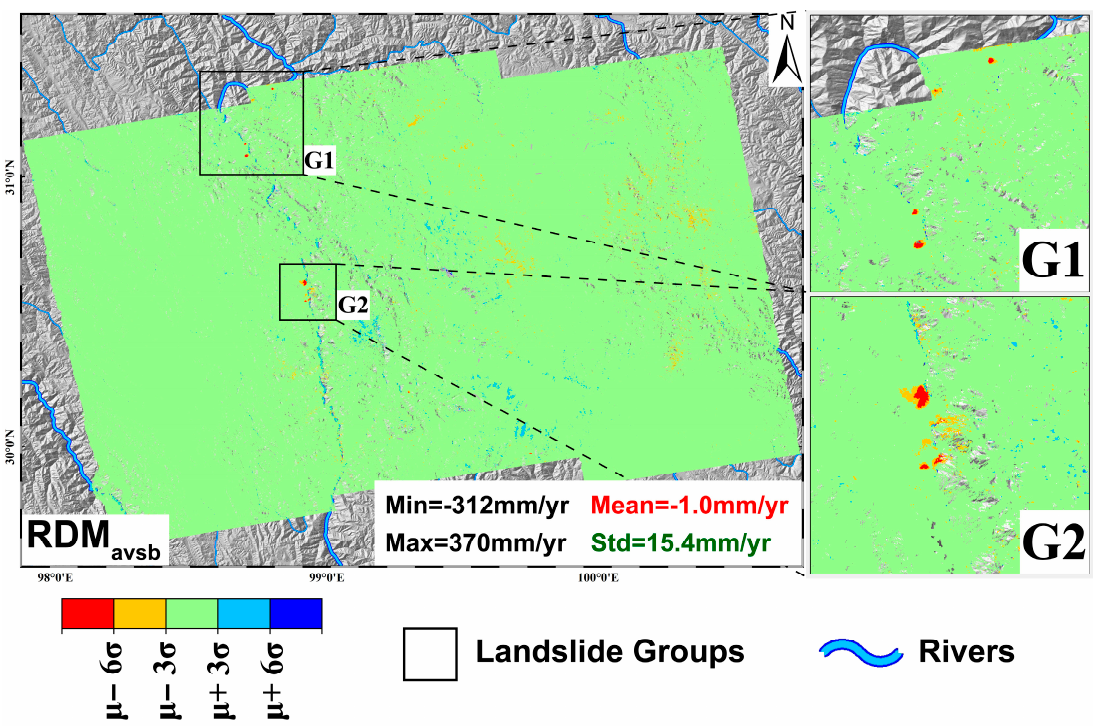
Figure 9. Annual velocity map obtained by SBAS.